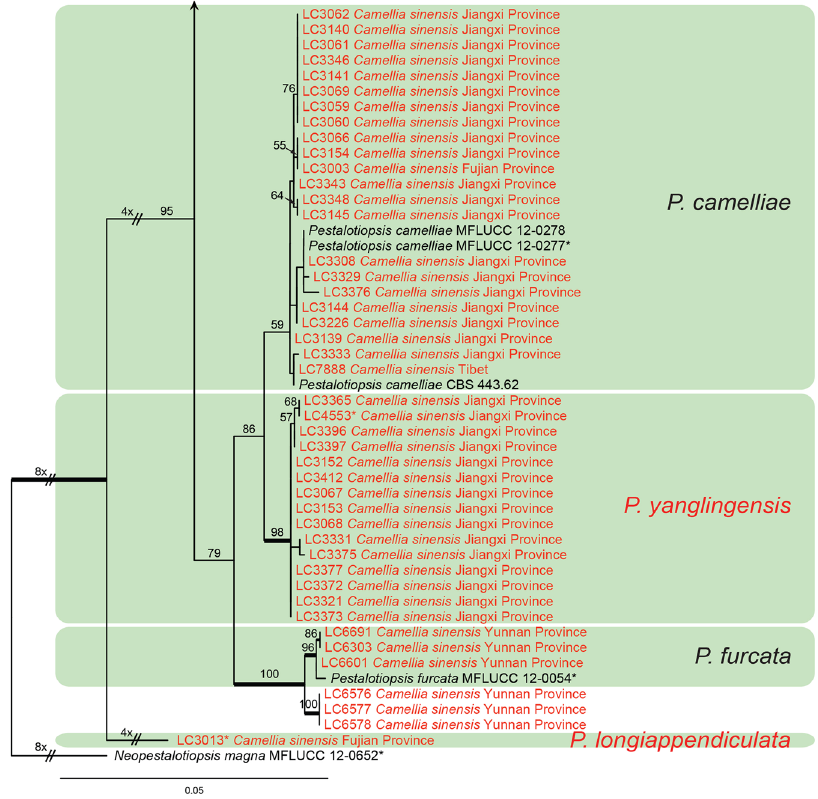
Figure 4. Part c of the phylogenetic tree of Pestalotiopsis